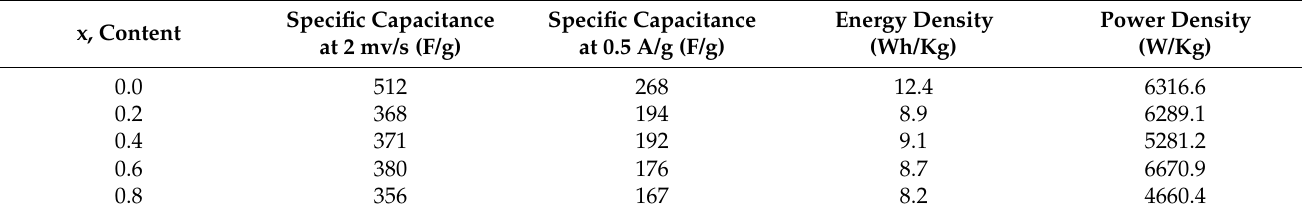
Table 4. Data of specific capacitance obtained from cyclic voltammetry, specific capacitance obtained from charge-discharge curves, energy density, and power density for Ni 1-x Al x Co 2 O 4 .